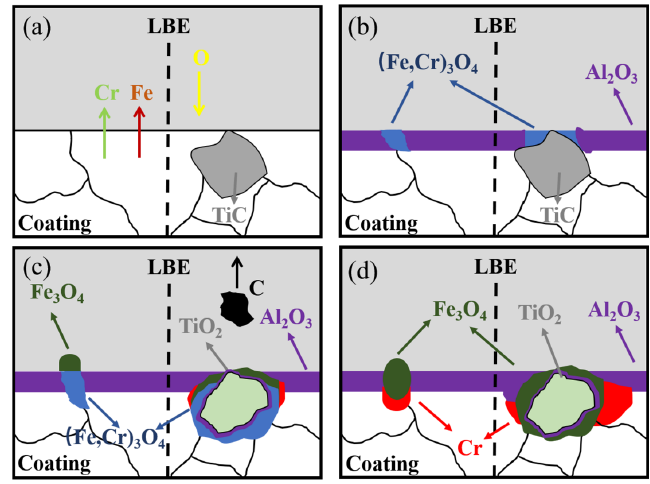
Figure 13. Corrosion mechanism of the coating in the static LBE at 500 ◦ C. ( a ) the origin of corrosion; ( b ) the first oxidation; ( c ) the oxidation of Fe-Cr spinel oxides and TiC; ( d ) the Cr enrichment.